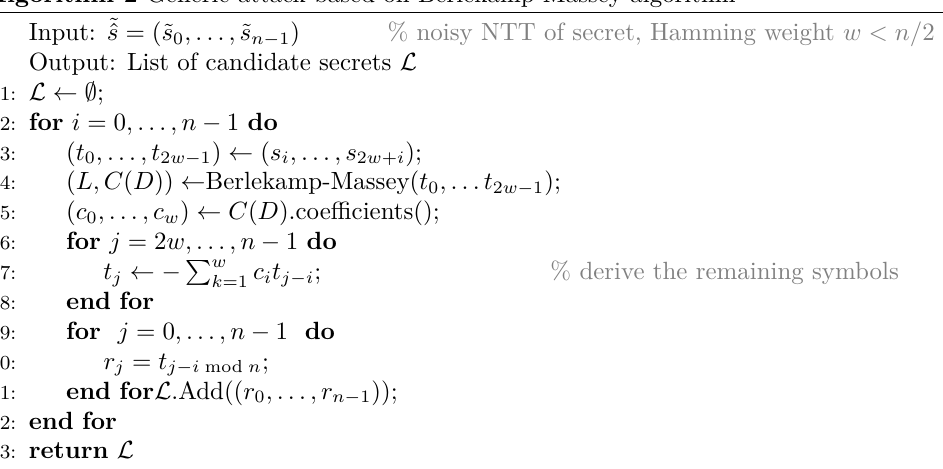
Algorithm 2 Generic attack based on Berlekamp-Massey